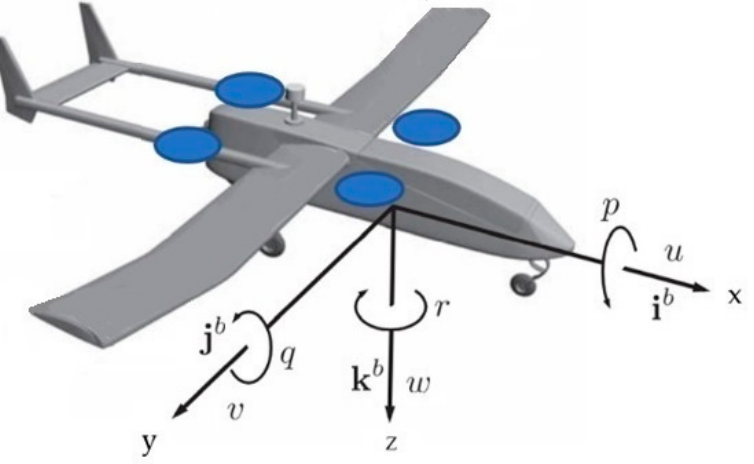
Figure 1. Aircraft body axes convention. The figure was taken and adapted from [5].